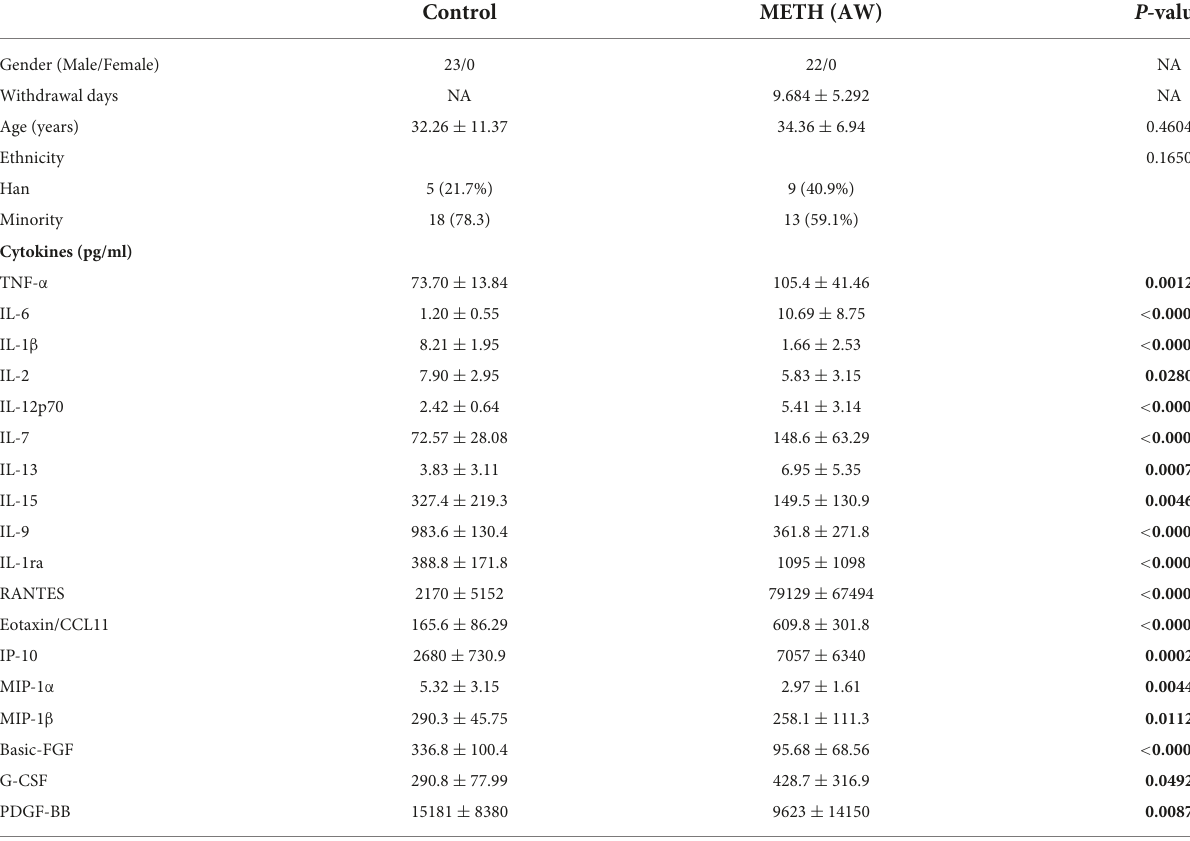
TABLE 1 The basic information and cytokine levels (pg/ml) of study participants.